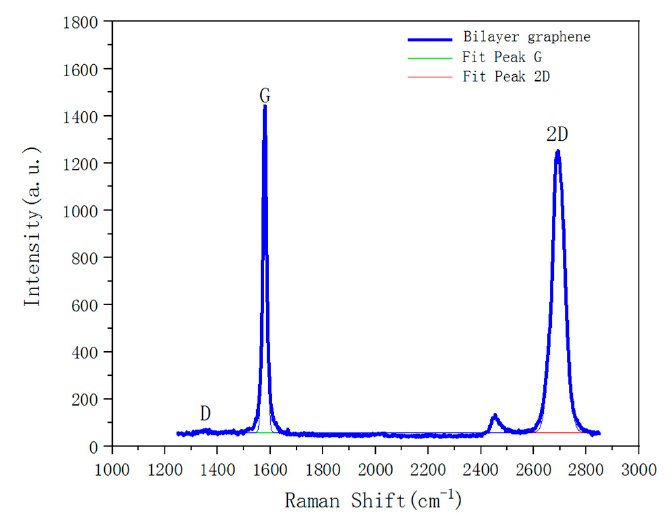
Figure 5. Raman frequency shift of bilayer graphene after transferring it to the PDMS substrate. The